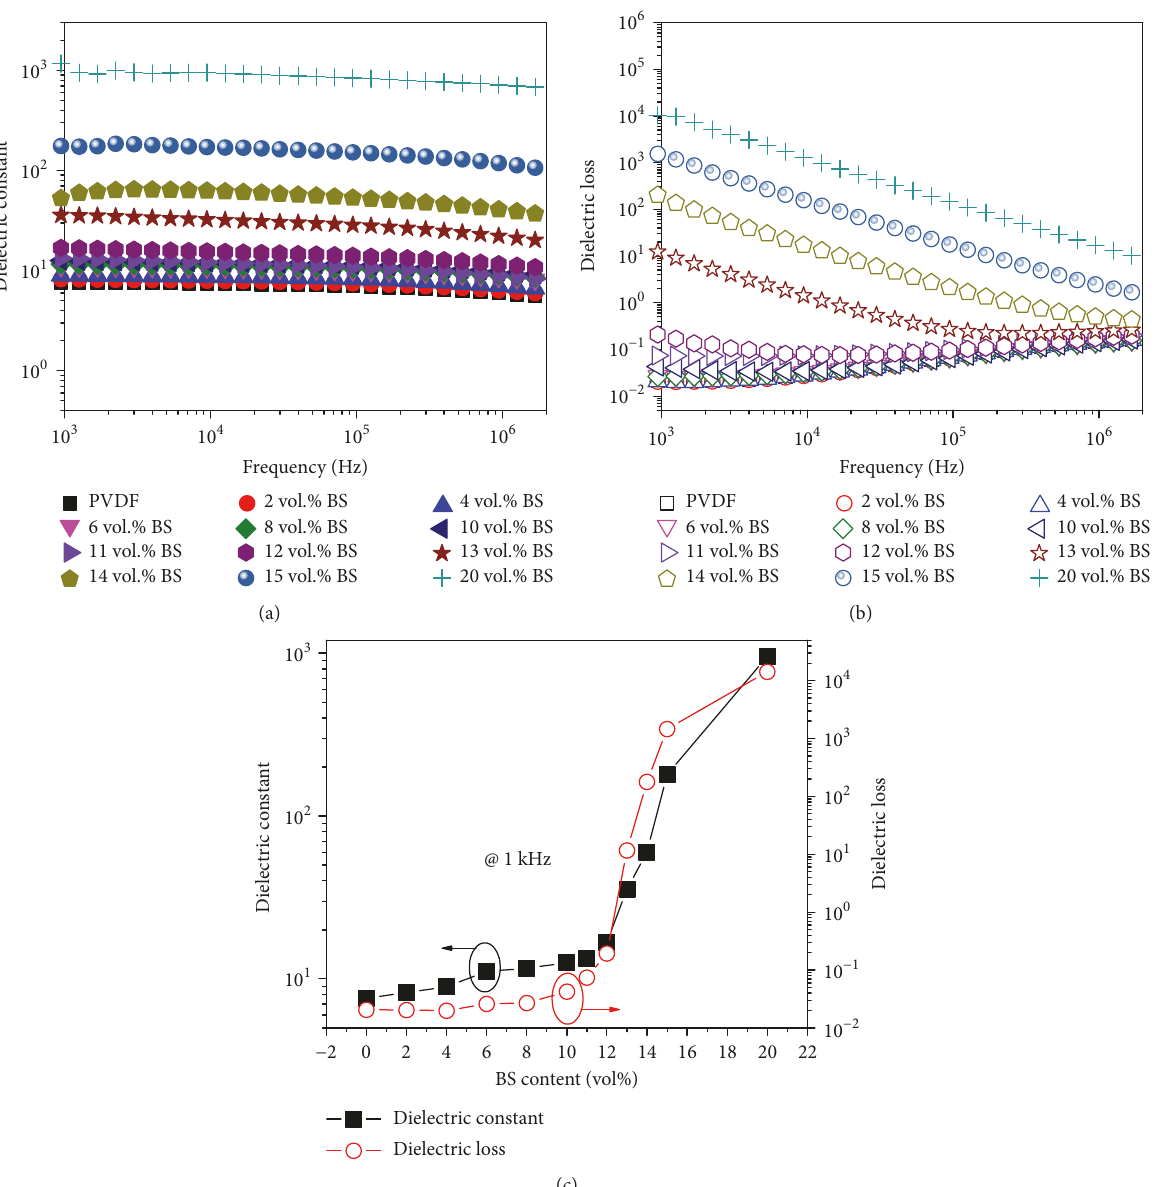
Figure 6: Frequency dependence of (a) dielectric constant and (b) dielectric loss of the Bi 2 Se 3 /PVDF nanocomposite films with different composition. (c) BS (Bi 2 Se 3 ) content dependence of dielectric constant and dielectric loss of the Bi 2 Se 3 /PVDF nanocomposite films, measured at room temperature and 1